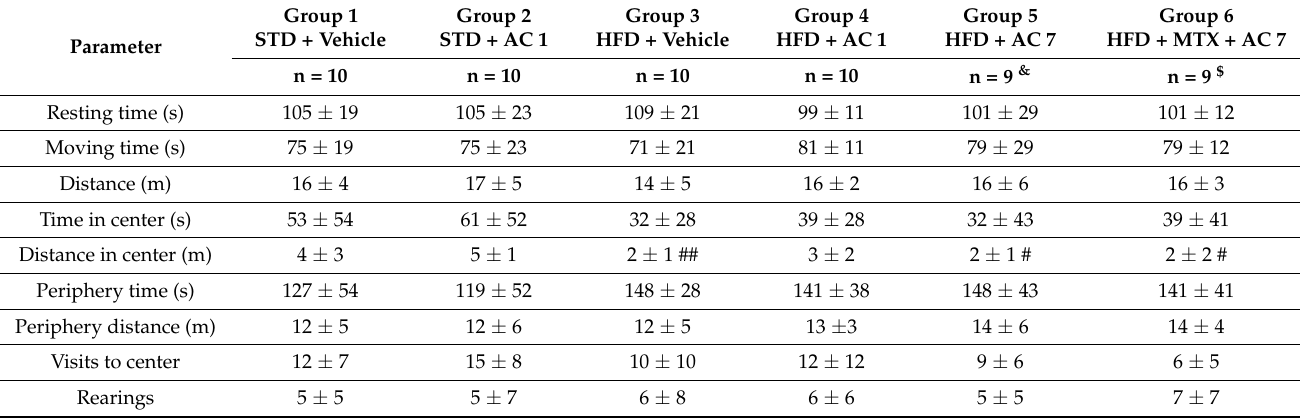
Table 8. The results of testing the motor activity of